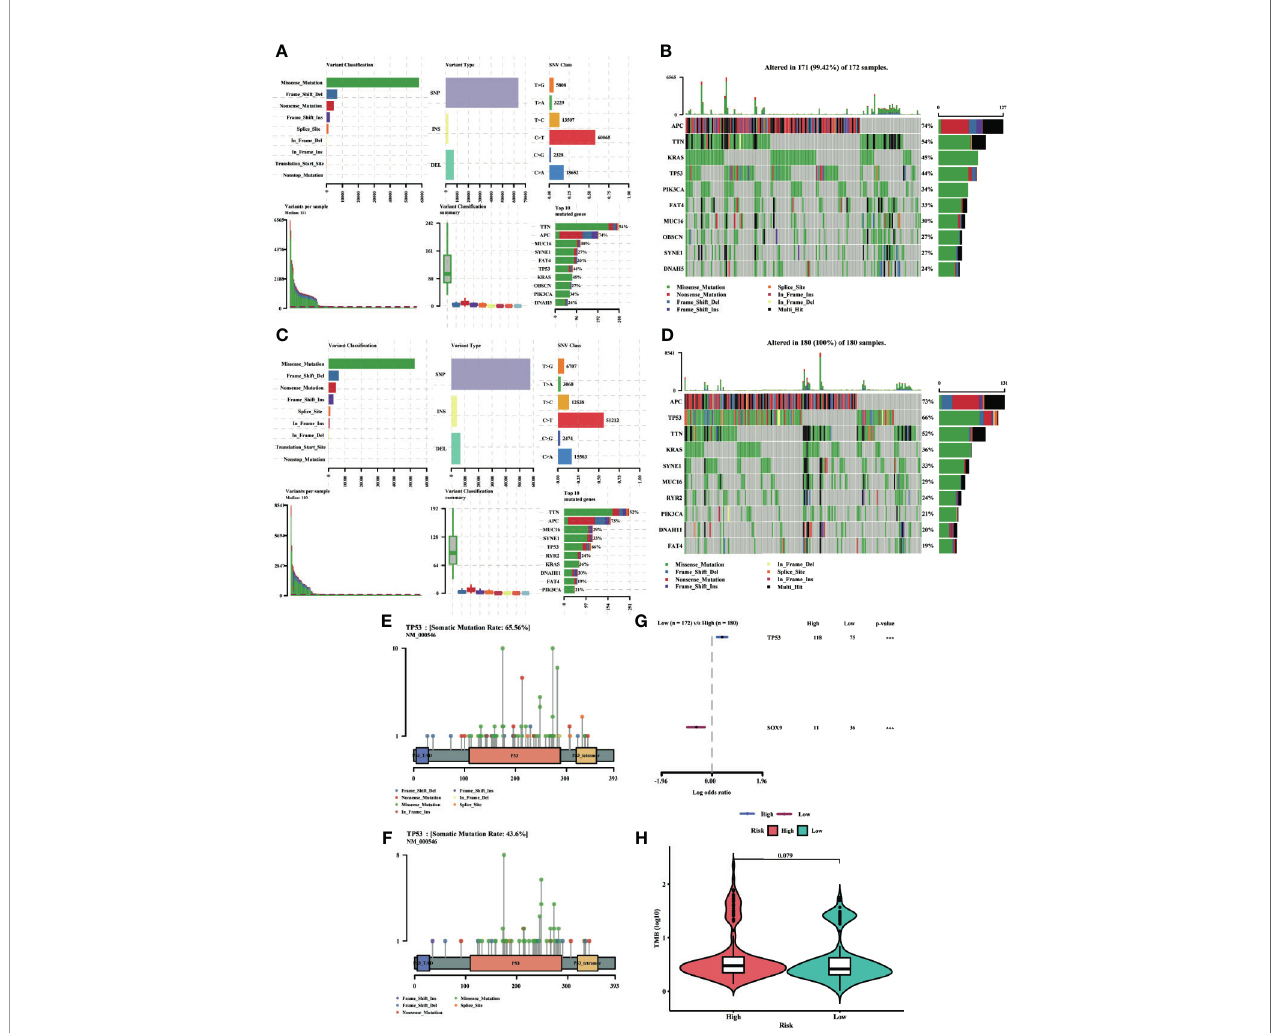
FIGURE 10 | MAF-summary plots and oncoplots of the somatic mutation between the high-risk (A, B) and low-risk (C, D) groups in the TCGA dataset. Lollipop charts of the mutated TP53 gene in the high-risk (E) and low-risk (F) groups. Forest plot (G) of the differentially somatic mutation and the violin plot (H) for the TMB scores between the high-risk and low-risk